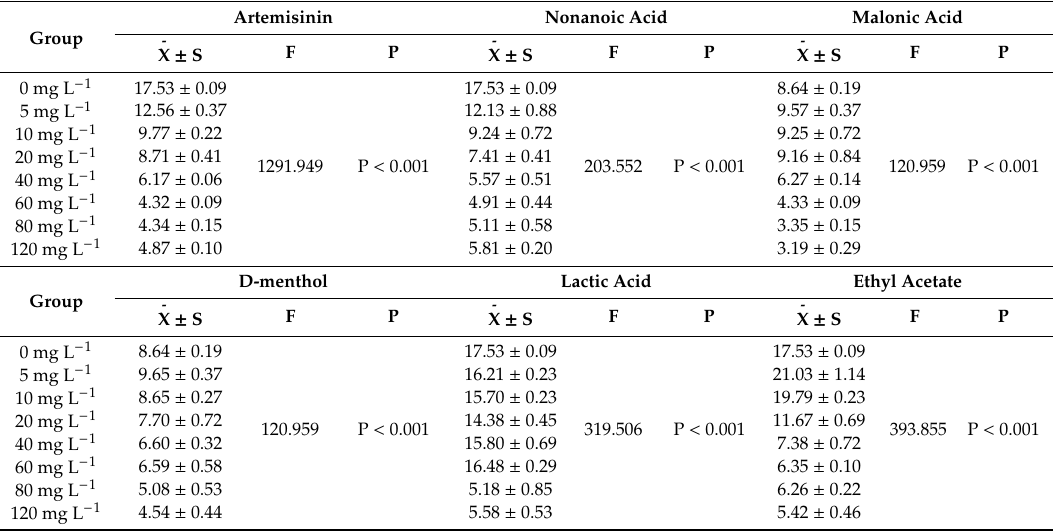
Table 2. The statistic results of algae cell densities (10 6 cells mL − 1 ) in concentration gradient experiments on the 3rd day (n = 3).